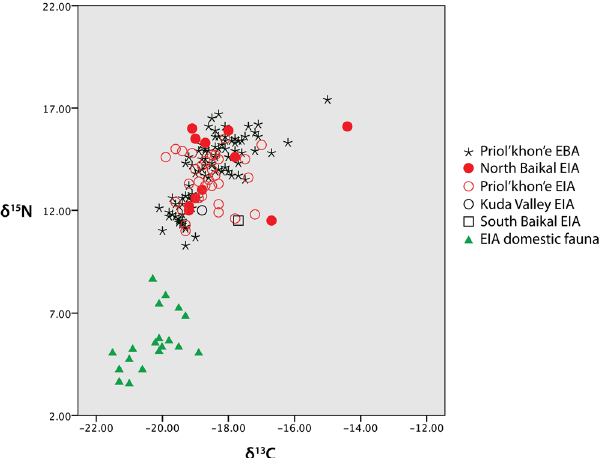
Figure 2. Stable isotope values for Early Bronze Age (EBA) and Early Iron Age (EIA) human bone collagen, and for EIA domestic fauna. Human samples are labeled by subregion and time